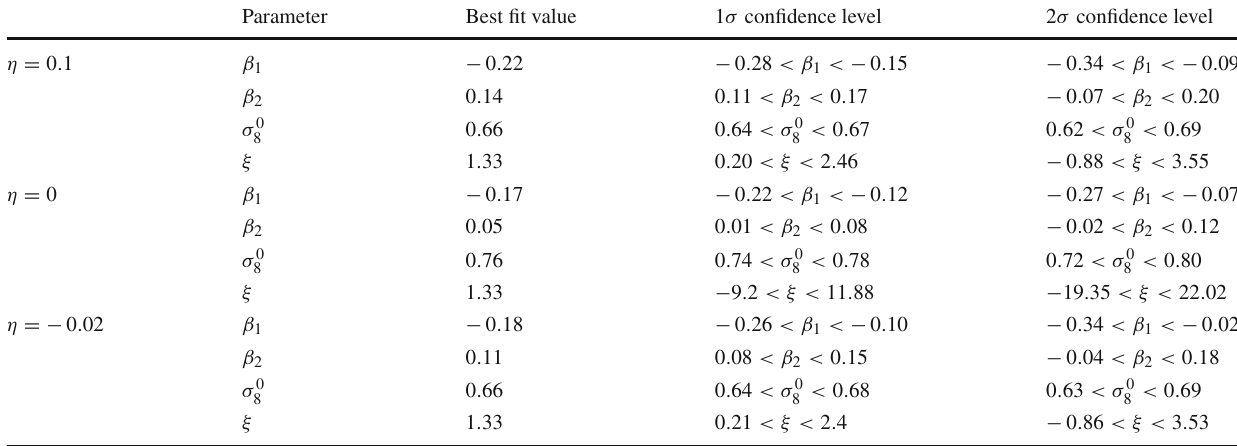
and also the initial condition ξ , for three different 8